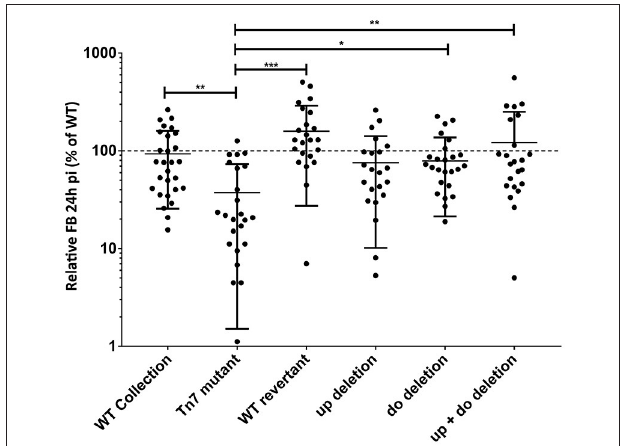
FIGURE 7 | Deletion of the Tn7 upstream and downstream regions and consequence on larvae fungal burden (FB). For each individual larva, the FB is expressed as a percentage relative to the mean of the wild-type group in the same experiment. All experiments were pooled in this graph. The mean value of each group is indicated with a black bar. The dotted line indicates the level of the mean of the wild-type strain set at 100%. Each mutant was tested at least twice using 10 larvae each time and once using 5 larvae (missing dots correspond to dead larvae). Statistical analyses were performed using a ROUT analysis to remove outliers (Motulsky and Brown, 2006), followed by a Kruskal-wallis (non-parametric ANOVA) analysis with a Dunn post-test to assess CFU differences relative to the wild-type strain (GraphPad Prism 7.02). The stars indicate the level of statistical significance: * p < 0.05, ** p < 0.01, *** p <